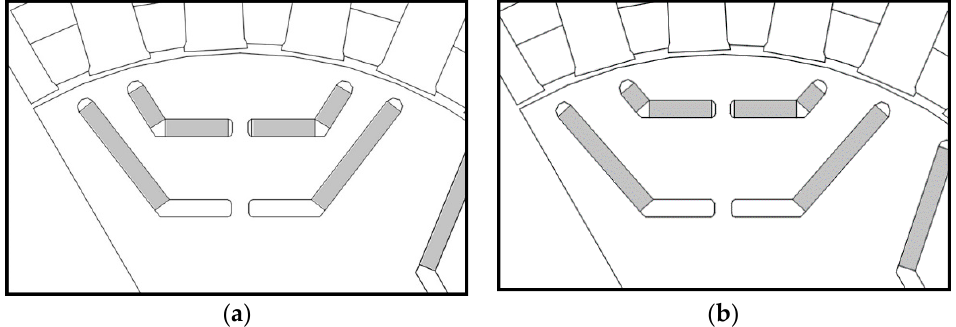
Figure 10. Permanent magnet structure: ( a ) Initial model; ( b ) Optimum model.